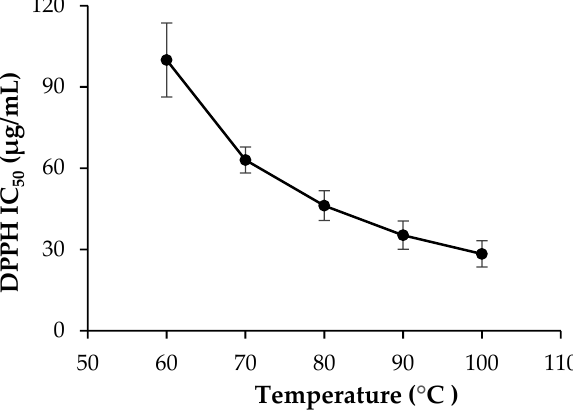
Figure 3. Effects of temperature on the DPPH scavenging activity of black tea.